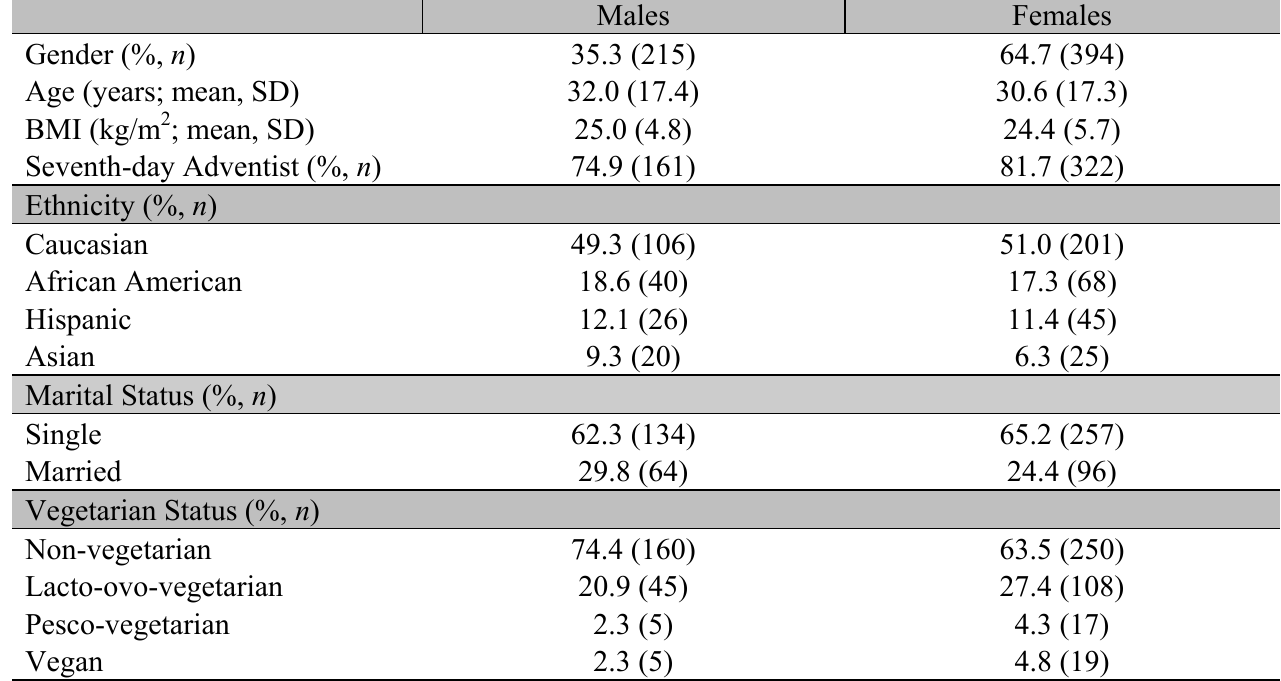
Table 2. Selected characteristics of the study population ( n =